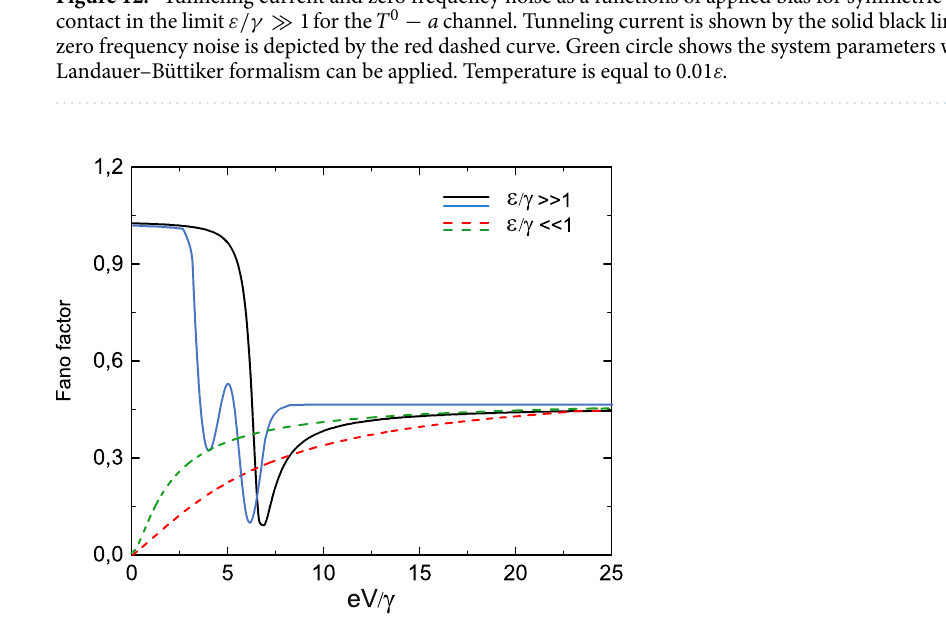
Figure 13. Fano factor as a functions of applied bias for symmetric tunneling contact for both T 0 channels in two limiting cases ε/γ S 0 S − − 1 is shown by the solid lines (black line corresponds to the T 0 ε/γ ≫ 0 0 channel) and the limiting case ε/γ S obtained for the S − − 0 a channel and blue line depicts results obtained for the S 0 line corresponds to the T − Temperature is equal to 0.01 ε